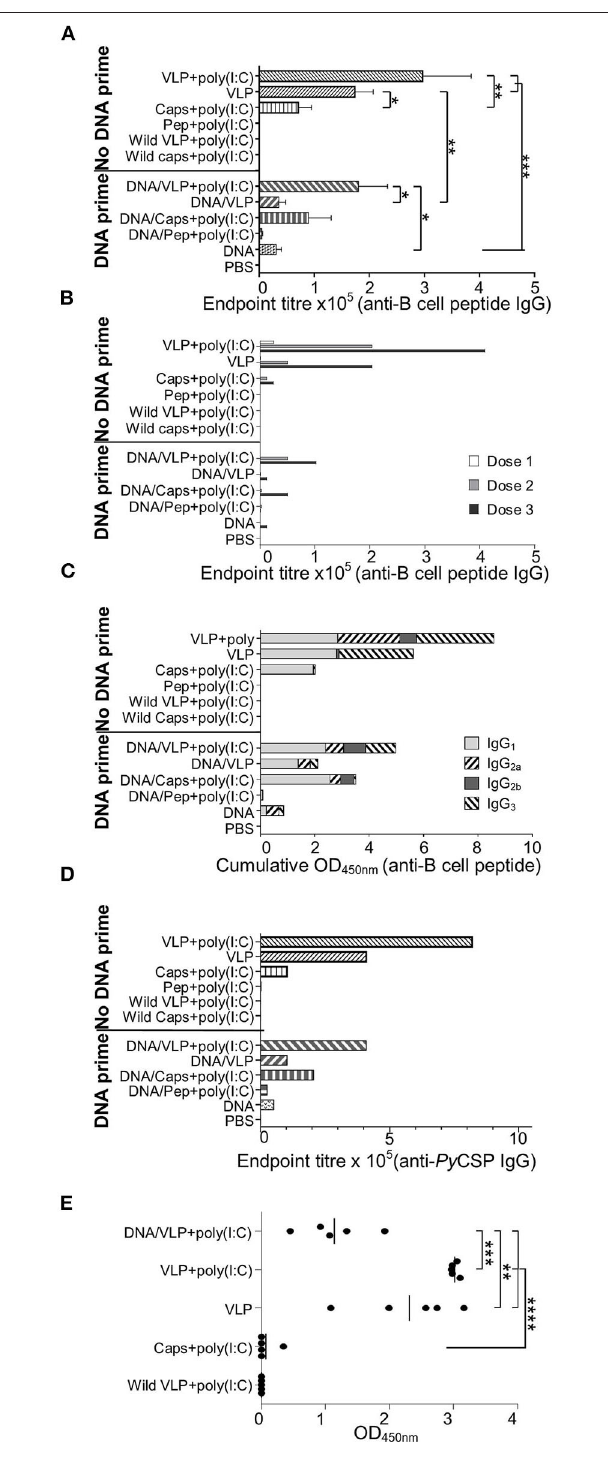
FIGURE 4 | Py CSP-specific antibody responses induced immunization with chimeric VLPs or capsomeres. BALB/c mice ( n = 5/group) were immunized with DNA, VLP, capsomeres or peptides in a three-dose homologous regimen or a heterologous DNA prime boost regimen as described in Figure 1 . Sera collected 14 days after each immunization and 5 days after the final immunization were analyzed either individually or pooled, by ELISA using the